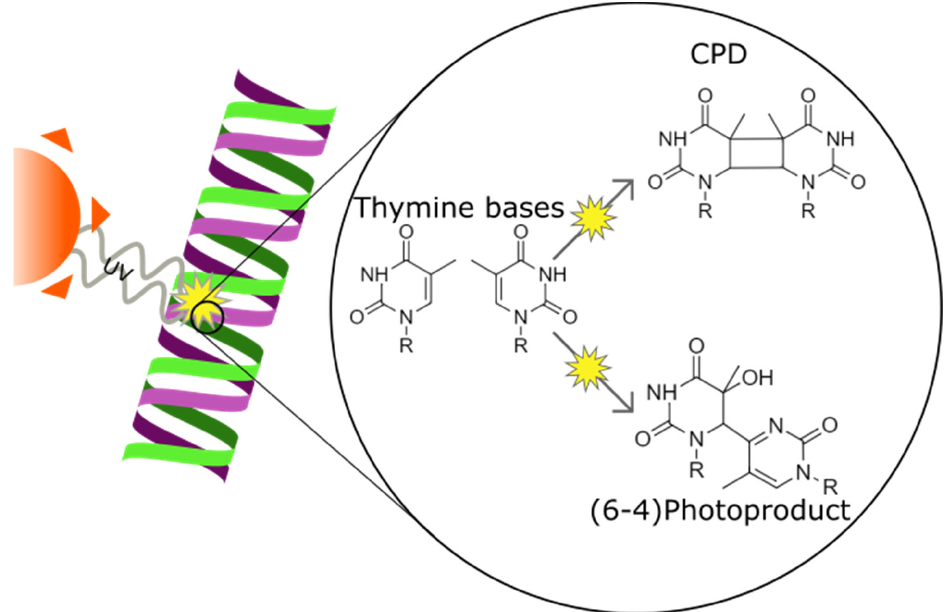
Figure 4. Ultraviolet radiation causing cyclobutane pirymidine dimer and pyrimidine-pyrimidone (6-4) photoproduct formation in a DNA strand between two thymine bases. The two forms of DNA damage differ in the position of the bond created between the two bases.